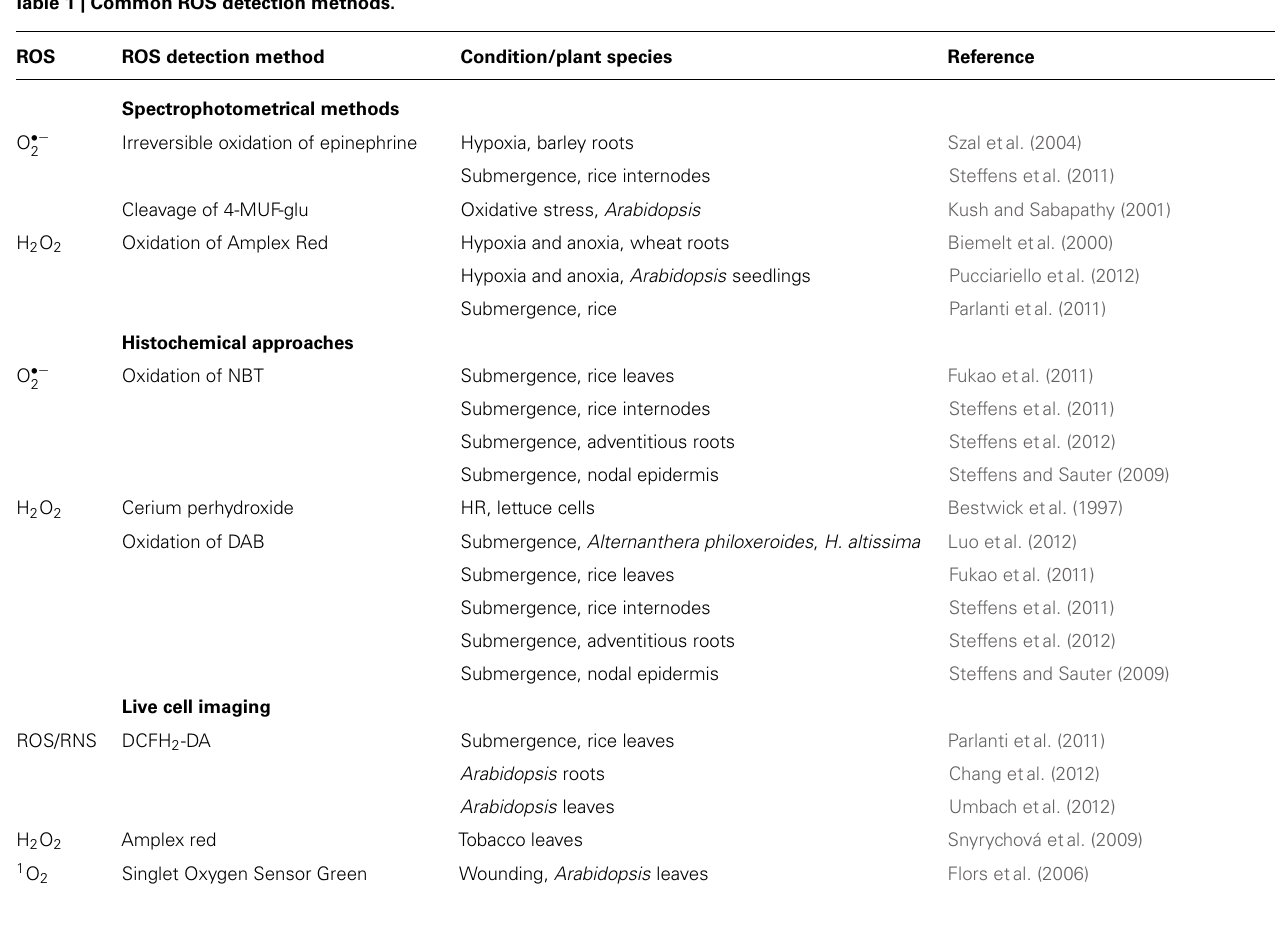
Table 1 | Common ROS detection methods. ROS ROS detection